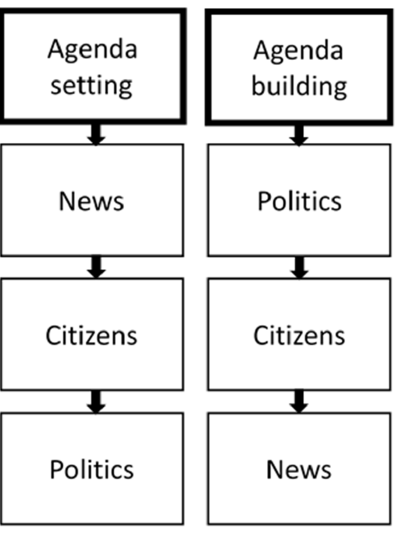
Figure 1. Information pipelines, as described by agenda setting and policy agenda